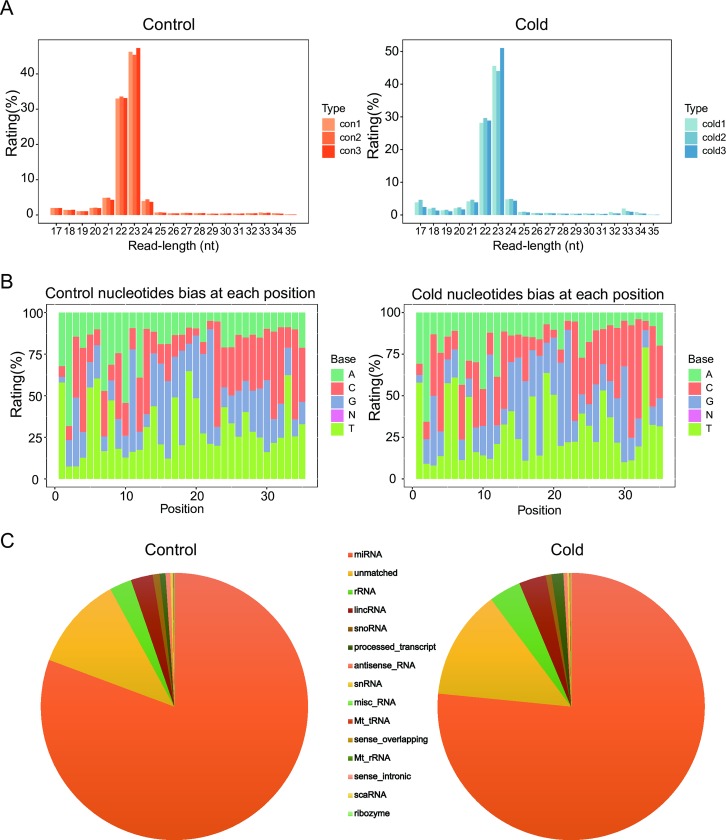
Statistics and classification of small RNAs.Read length distribution of small RNA libraries (A) and nucleotides bias at each position of miRNA (B) for control or cold acclimation condition. (C) An overview of the frequency of different RNA species present in libraries from each group. miRNA: microRNA, unmatched: unmatched reads, rRNA: ribosomal RNA, lincRNA: long intergenic non-coding RNA, snoRNA: small nucleolar RNA, snRNA: small nuclear RNA, misc_RNA: miscellaneous RNA, Mt_tRNA: mitochondrial transfer RNA, Mt_rRNA: mitochondrial ribosomal RNA, scaRNA: small cajal body-specific RNA.